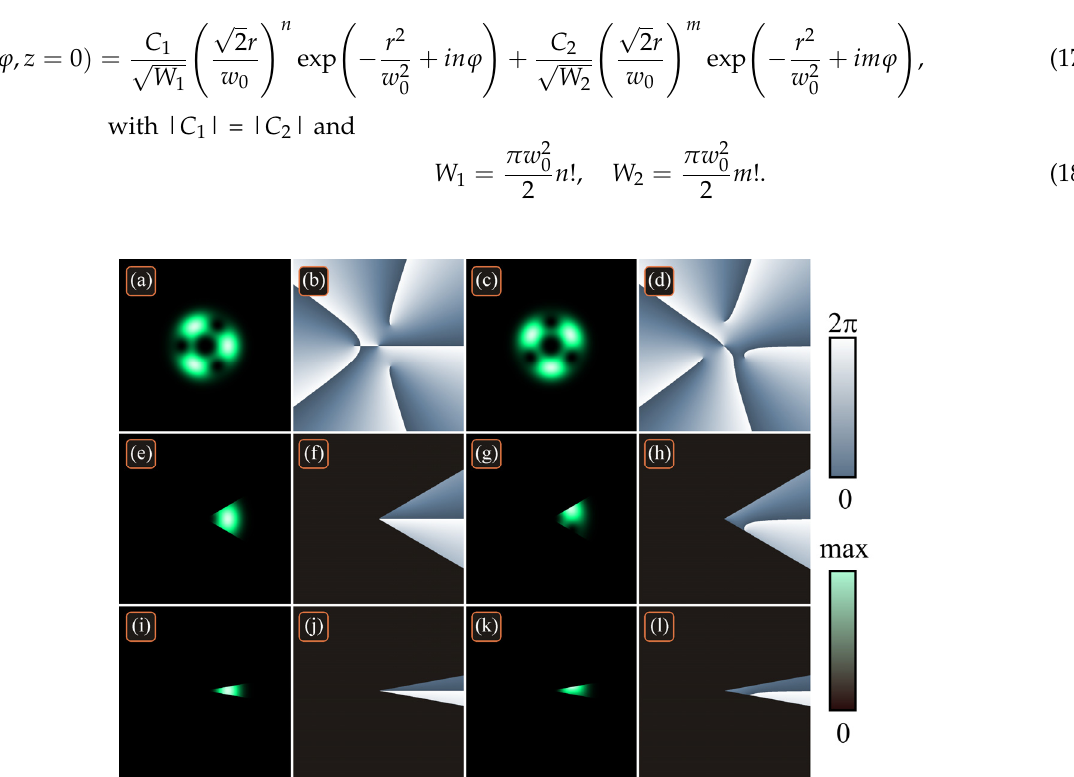
Figure 2. Intensity (1st and 3rd columns) and phase (2nd and 4th columns) distributions of two different superpositions of two single-ringed LG beams with the same energies passing through a sector aperture with different angle.